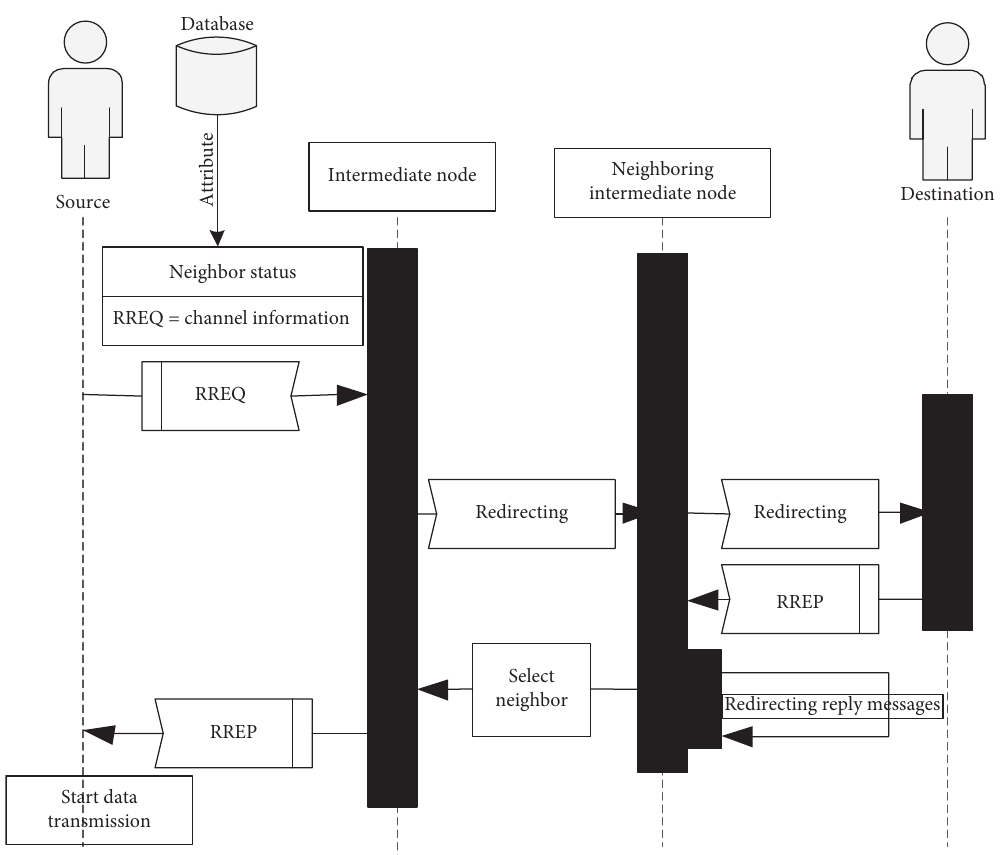
Figure 3: Message exchange process using learning